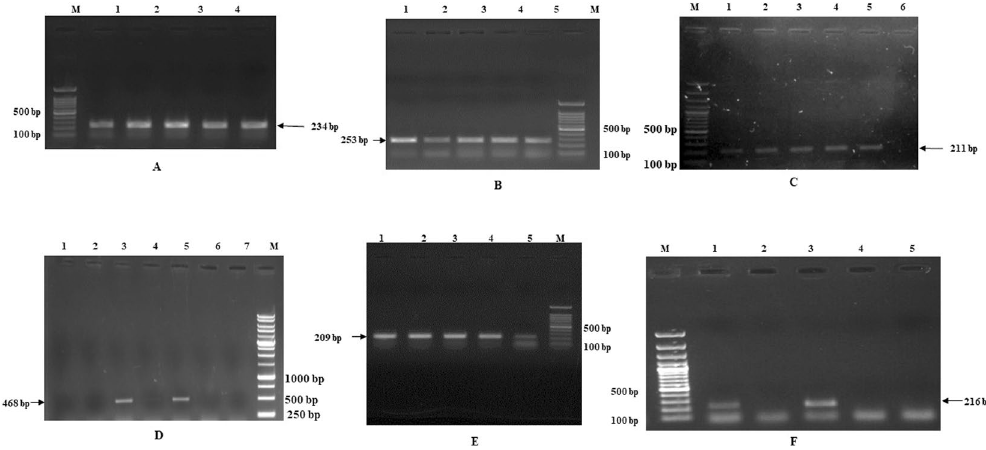
Figure 1. ( A ) Agarose gel Electrophoresis of UL21 PCR amplicon (234 bp) at time points after cycloheximide treatment of BoHV-1 infected MDBK cells. Lane M: 100bp DNA marker (Thermo scientific). Lane 1: 1 hours. Lane 2: 2 hours. Lane 3: 3hours. Lane 4: 4 hours. Lane 5: 5 hours. ( B ) Agarose gel Electrophoresis of UL34 PCR amplicon (253 bp) at time points after Cycloheximide treatment of BoHV-1 infected MDBK cells. Lane 1: 5 hours. Lane 2: 4 hours. Lane 3: 3 hours. Lane 4: 2 hours. Lane 5: 1 hours. Lane M: 100bp DNA marker (Thermo scientific). ( C ) Agarose gel Electrophoresis of UL33 PCR amplicon (211 bp) at time points after Cycloheximide treatment of BoHV-1 infected MDBK cells. Lane M: 100bp DNA marker (Thermo scientific). Lane 1: 1 hours. Lane 2: 2 hours. Lane 3: 3 hours. Lane 4: 4 hours. Lane 5: 5 hours. Lane 6: healthy MDBK used as negative control. ( D ) Agarose gel Electrophoresis of gB PCR amplicon (468 bp) at time points with and without Cycloheximide treatment of BoHV-1 infected MDBK cells in late hours. Lane M: 100bp DNA marker (Thermo scientific). Lane 1: No PCR product of gB gene after 12 hour post infection of BHV-1 without treatment of cycloheximide. Lane 2: No PCR product of gB gene after 12 hour post infection of BHV-1 with treatment of cycloheximide. Lane 3: PCR product of 468 bp of gB gene after 14 hour post infection of BHV-1 without treatment of cycloheximide. Lane 4: No PCR product of gB gene after 14 hour post infection of BHV-1 with treatment of cycloheximide. Lane 5: PCR product of 468bp of gB gene after 16 hour post infection of BHV-1 without treatment of cycloheximide. Lane 6: No PCR product of gB gene after 16 hour post infection